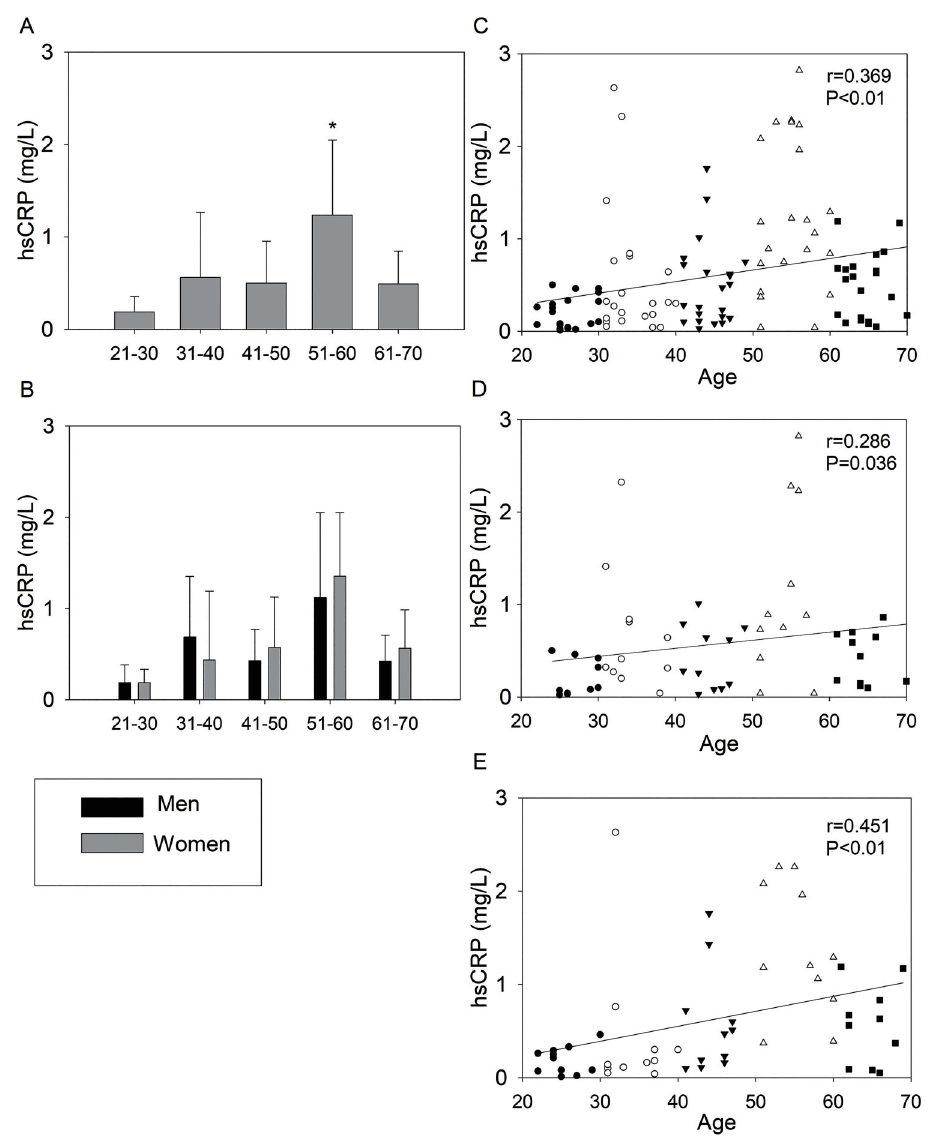
Figure 1. High sensitivity C-reactive protein (hsCRP) of the 110 volunteers ( A ) and divided by gender ( B ). Data are reported as means ± SD. *P o 0.05 compared to all the other age groups (two-way analysis of variance). hsCRP as function of age of the 110 volunteers (cid:3) : 21 – 30; J : 31 – 40; . : 41 – 50; D : 51 – 60; ’ : 61 – 70. Spearman correlation coef fi cient ( C ), men ( D ), and women ( E ).